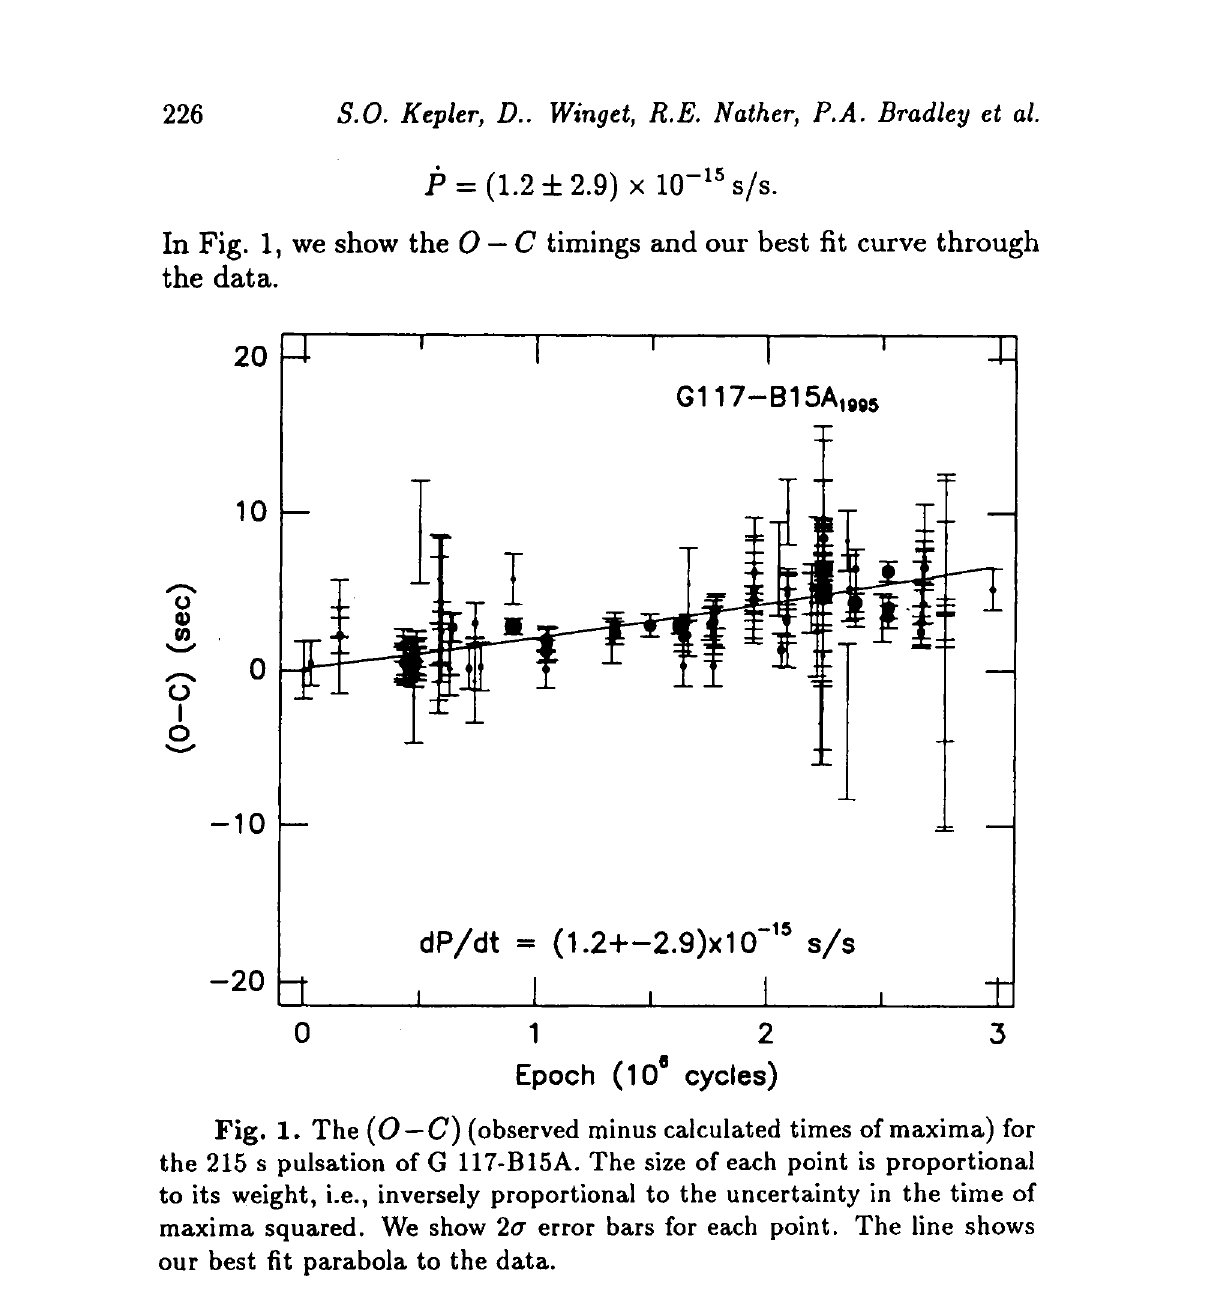
Fig. 1. The (O — C) (observed minus calculated times of maxima) for the 215 s pulsation of G 117-B15A. The size of each point is proportional to its weight, i.e., inversely proportional to the uncertainty in the time of maxima squared. We show 2cr error bars for each point. The line shows our best fit parabola to the